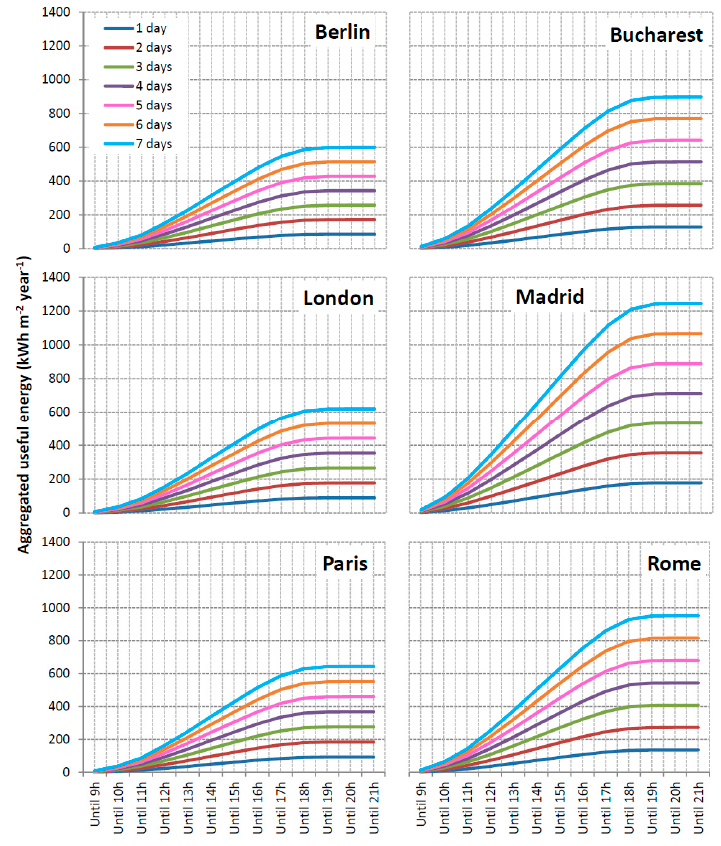
Figure 4. Annual energy delivered to the tank, depending on time of day and the number of days per week that the SWH is used.